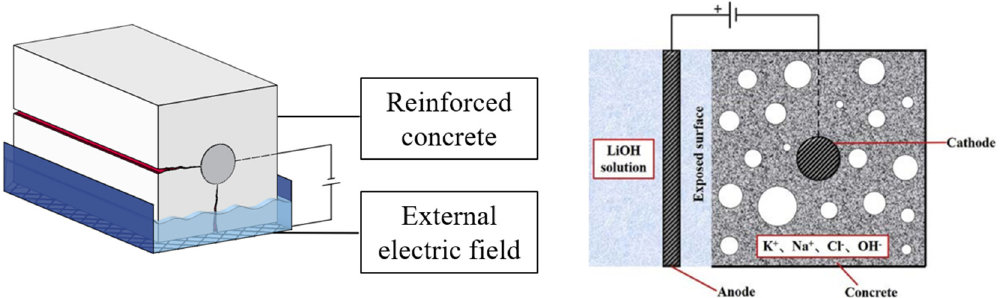
Electrochemical rehabilitations for